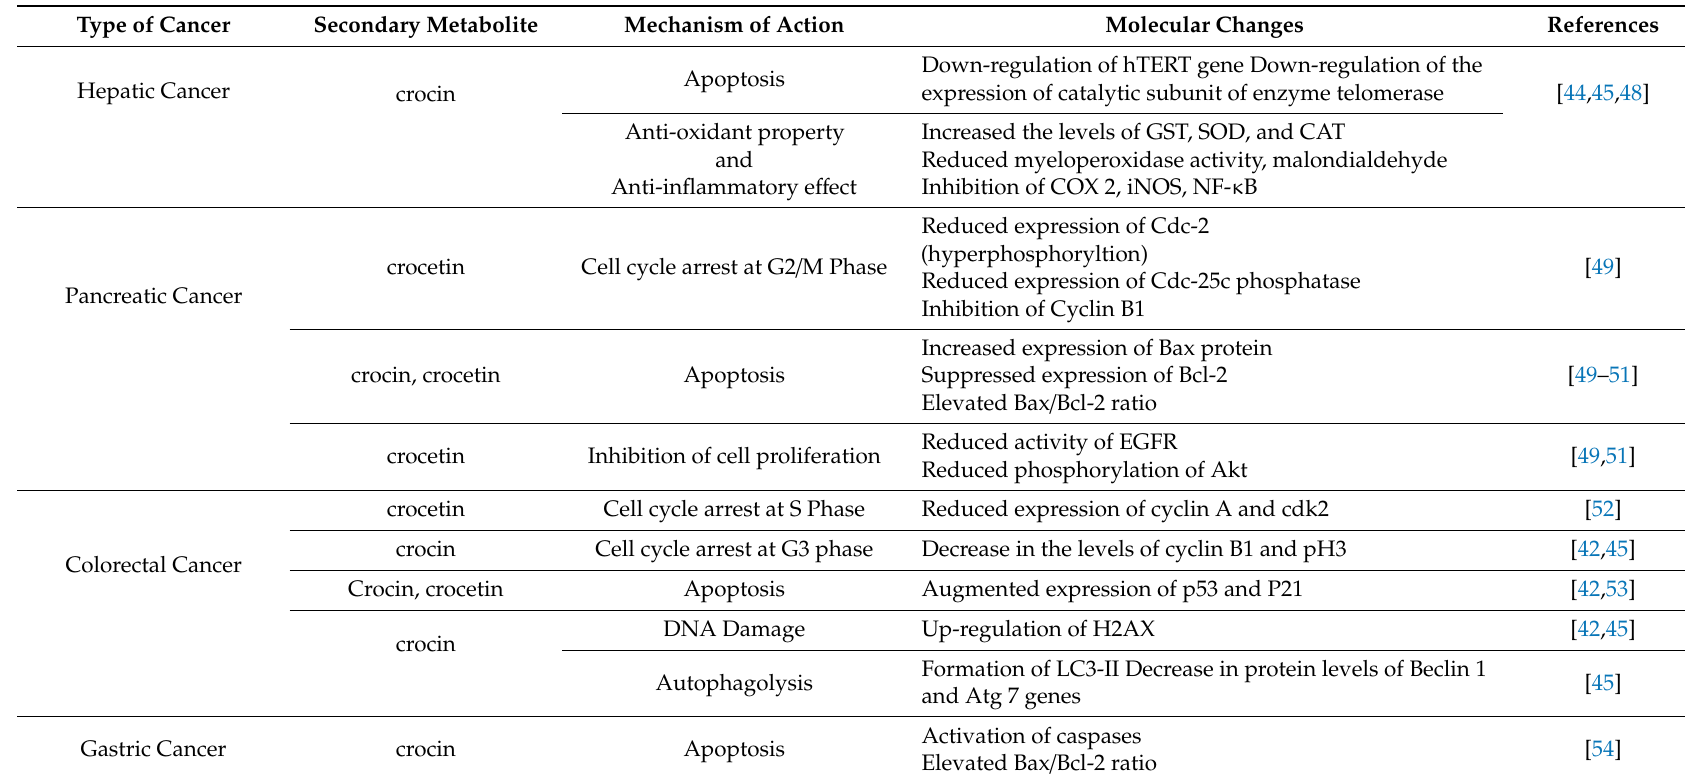
Table 3. Molecular mechanisms by which extracts of sa ff ron exert anti-cancer activity in GI